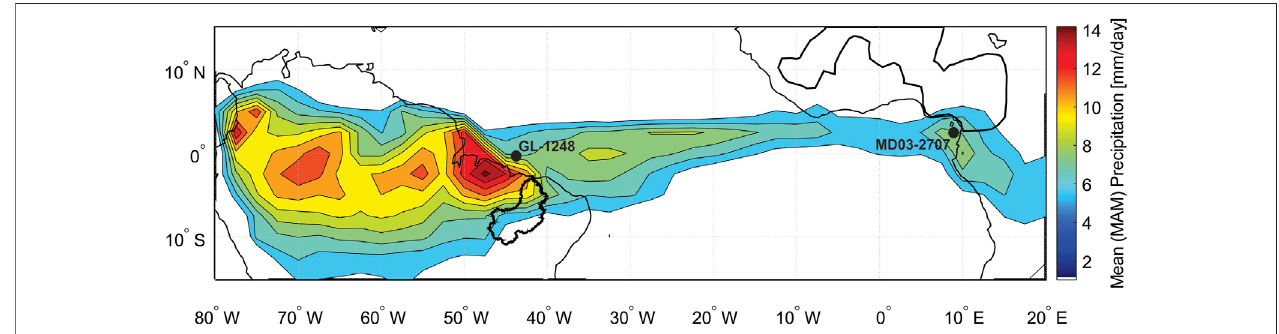
FIGURE 1 | Location of sediment cores GL-1248 (black dot) and core MD03-2707 (Weldeab et al., 2007) (black dot). Color-scale exhibits the mean precipitation (mm/day)betweenMarchandMayextractedfromGPCPdatasetstoredatNOAA/ESRLPSD(Adleretal.,2003)version2.3.TheParnaíbaRiverBasinandSanaga/Niger River Basin (black contours) are displayed in the